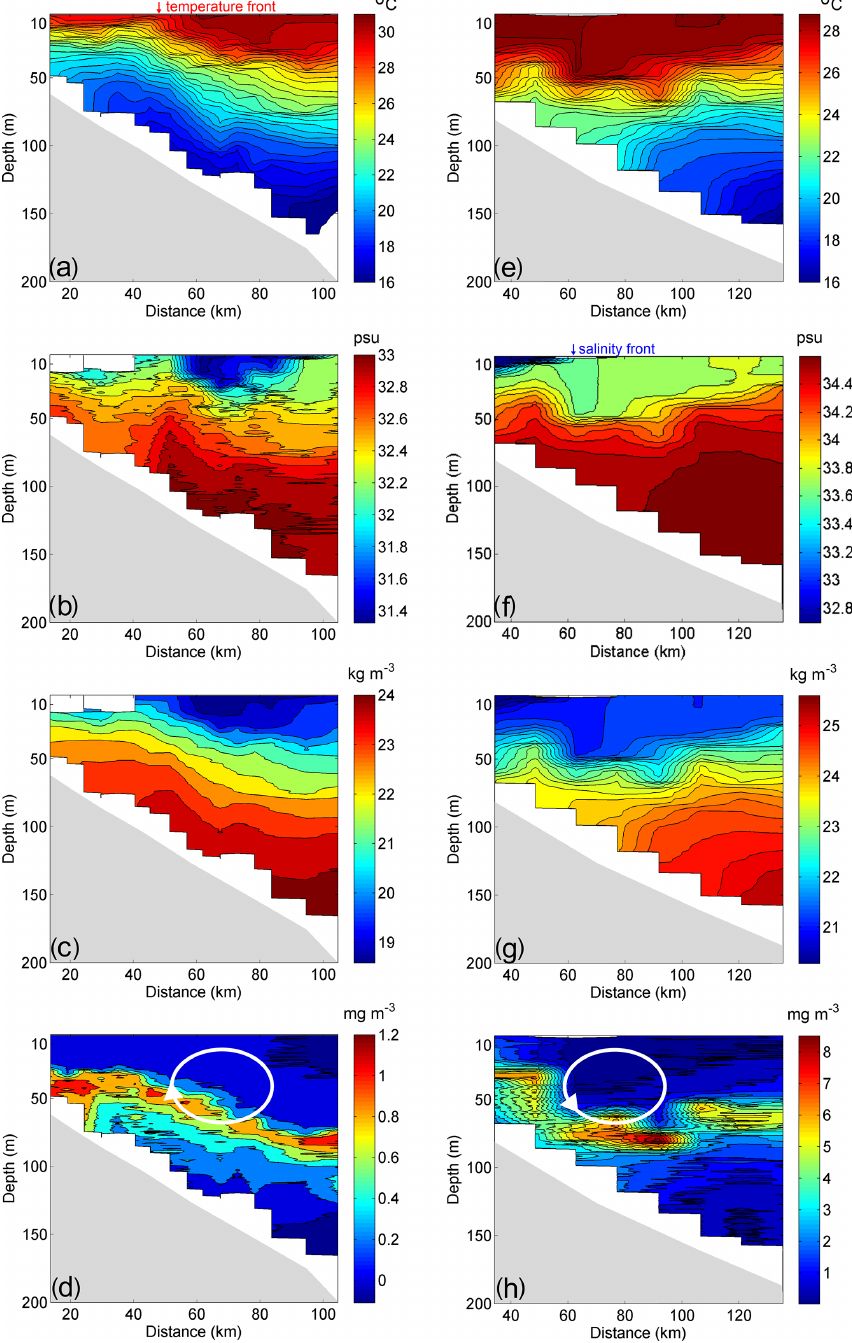
Figure 8. Oceanographic cruise data collected on (a–d) 14–15 July 2021 and (e–h) 2–3 October 2019: (a) and (e) temperature distributions; (b) and (f) salinity distributions; (c) and (g) potential density distributions; and (d) and (h) Chl a distributions. The arrows indicate the location of the temperature and salinity front near the sea surface. The white circle is a diagrammatic sketch for upwelling and downwelling